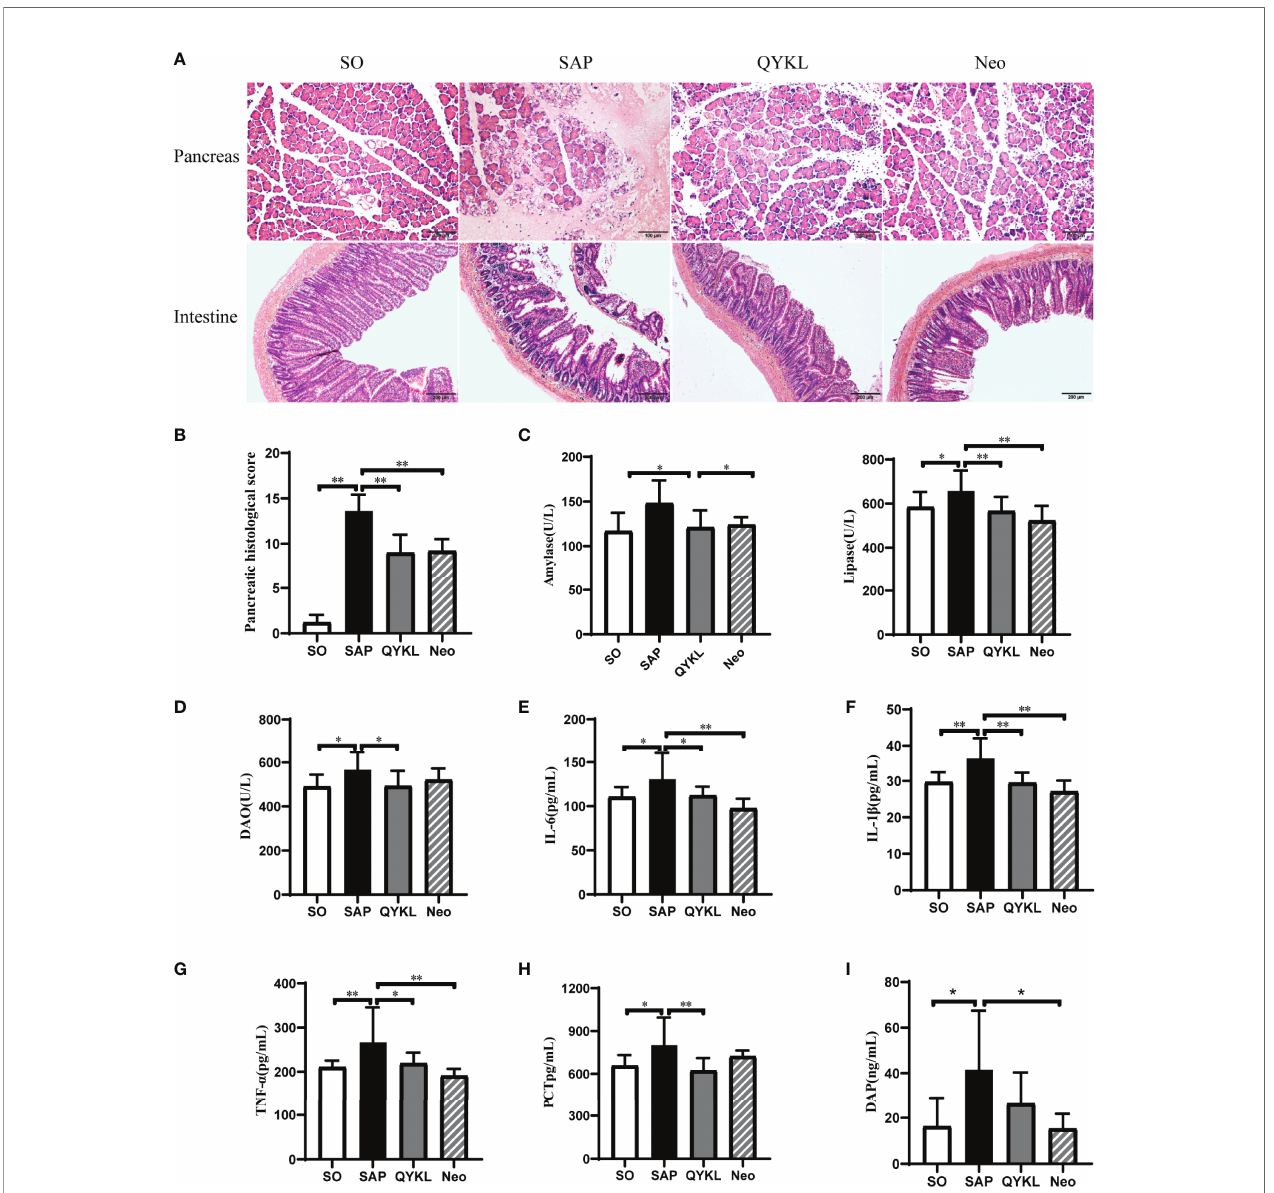
FIGURE 3 | Both Qingyi Keli and neomycin alleviated pancreatic injuries, serum enzymatic indices, intestinal damage and reduced plasmatic in fl ammatory factors in SAP rats. (A) Histological observation of the pancreas (HE, ×200) and intestine (HE, ×100) among the four groups; (B) Pancreatic histological scoring among the four groups; (C) Amylase and lipase levels in the serum among the four groups. (D) DAO levels in serum among the four groups; (E – H) IL-6, IL-1 b , TNF- a and PCT levels in the serum among the four groups; (I) Determination of serum DAP levels in different animal model groups. QYKL, Qingyi Keli treatment group; Neo, neomycin pretreatment group. ANOVA test (n = 5 in each group of Panel B , n ≥ 7 in each group of Panel C – H , n ≥ 7 in each group of Panel I ); * p < 0.5, ** p <